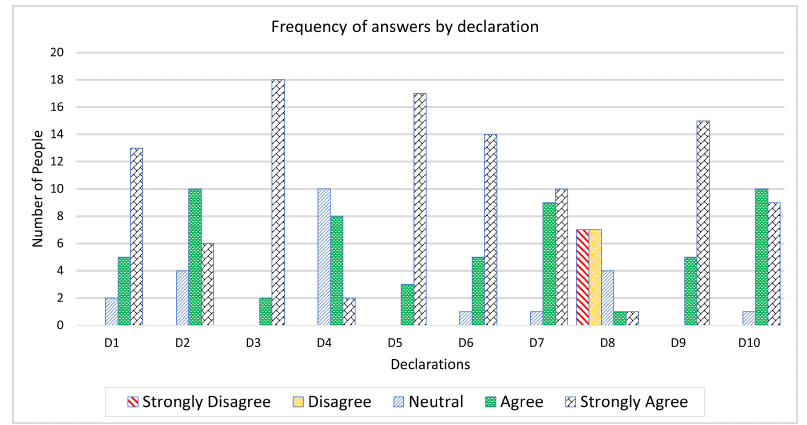
Figure 6. Frequency of answers by